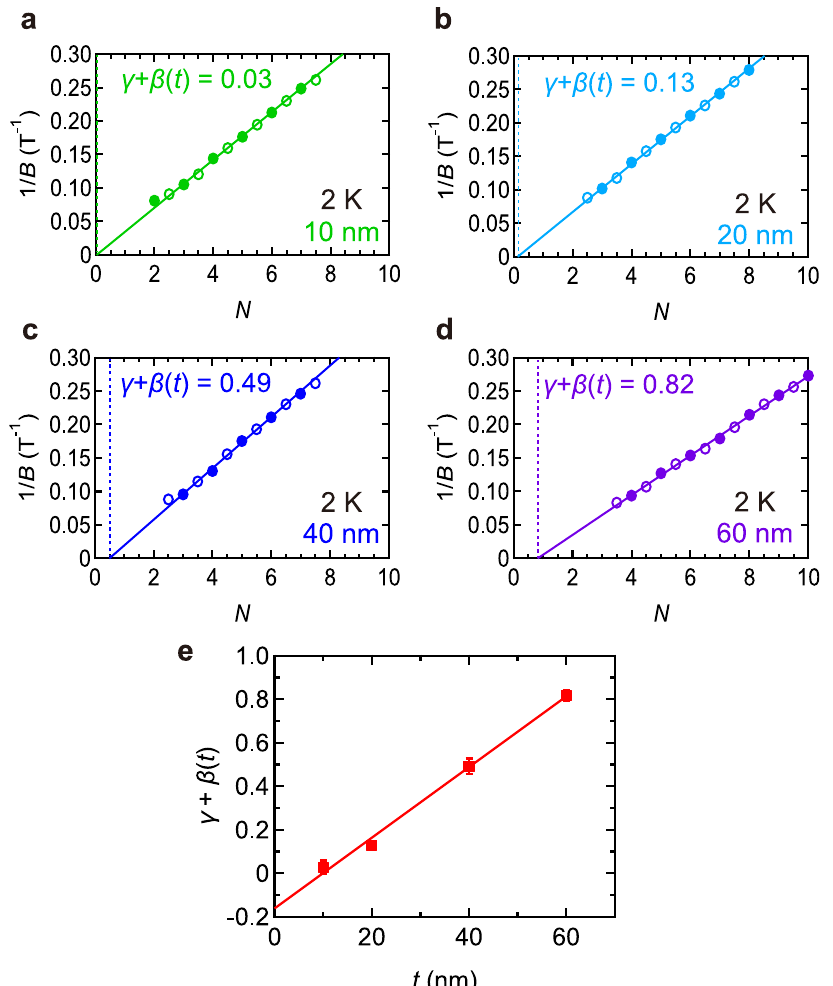
Fig. 10 Thickness t dependence of the LL fan diagram of the conductivity maximum for the SrRuO 3 fi lms. a t = 10 nm, b 20 nm, c 40 nm, and d 60 nm. The fi xed slopes of the linear fi ttings are obtained by the frequency F . All plotted data points were used in the linear fi ttings. γ þ β ð t Þ is the phase shift in Eq. (4). e Thickness t dependence of the γ þ β ð t Þ . The red line represents the linear fi tting. The error bars are de fi ned as the standard deviation of the linear fi ttings in a – d .